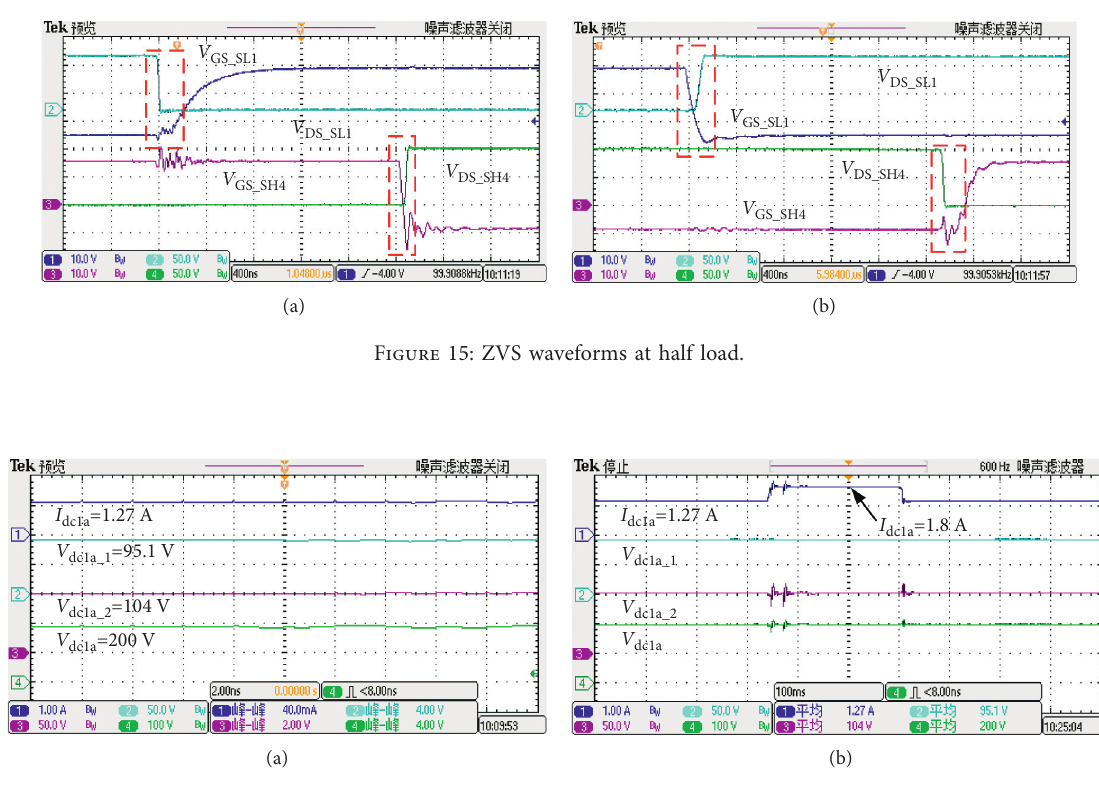
Figure 16: Steady-state output waveforms at half load: (a) steady state at half load and (b) dynamic.